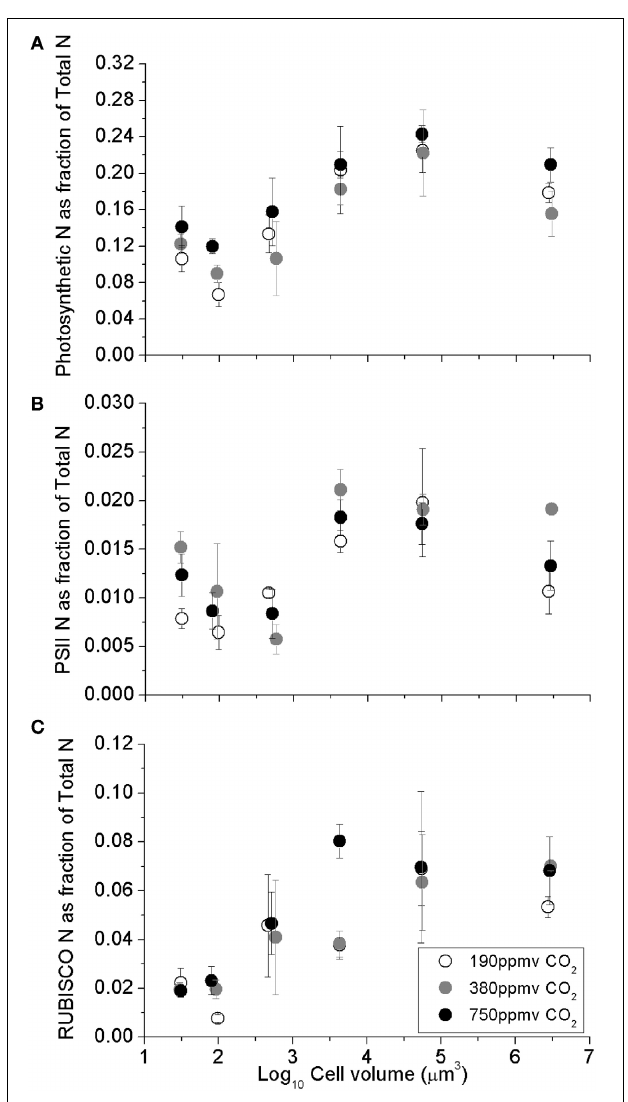
FIGURE 2 | (A) Sum of major photosynthetic complexes (FCP, PSII, Cytb6f, PSI, RUBISCO), (B) Photosystem II, and (C) The fraction of total cellular N allocated to RUBISCO, as a function of log10 cell volume. Cultures were grown under pCO2 190ppmv (open symbols); 380ppmv (shaded symbols) or 750ppmv (black symbols). Vertical error bars indicate standard deviation, n = 3 −